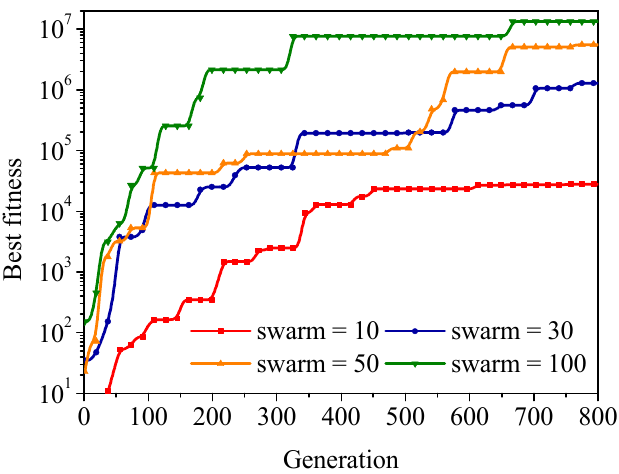
Figure 3. The best fitness change of different swarm sizes under the ISPSO algorithm.